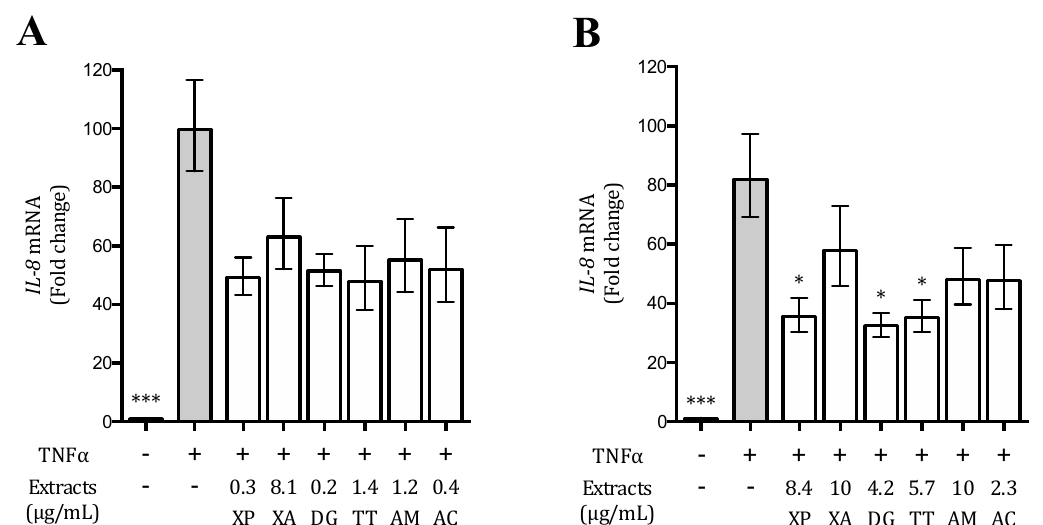
Figure 3. E ff ect of the extracts on IL-8 mRNA levels in human gastric adenocarcinoma (AGS) ( A ) and gastric epithelial (GES-1) ( B ) cells. Data are expressed as fold changes versus stimulated control (grey bar). * p < 0.05; *** p < 0.001.